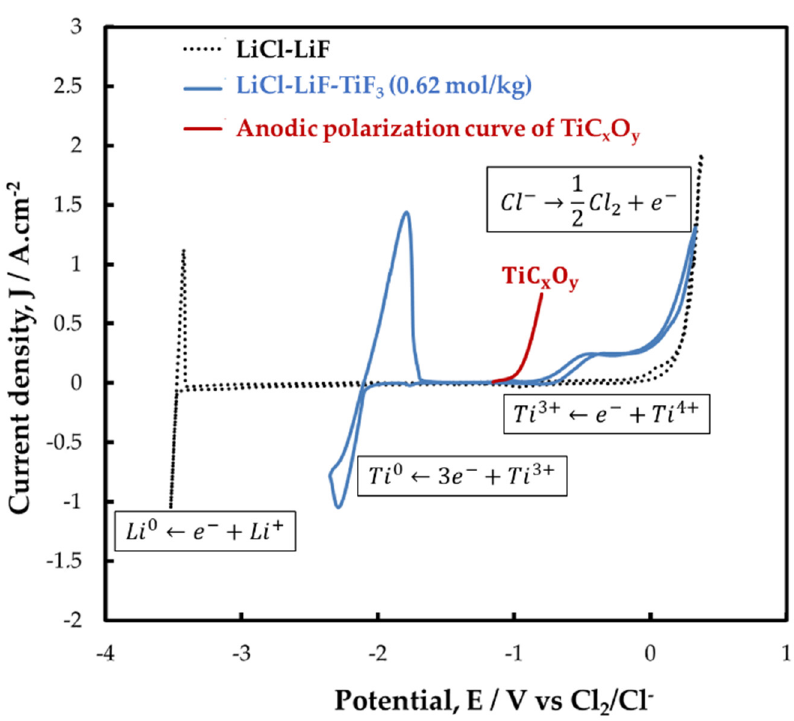
Figure 2. Cyclic voltammograms on a tungsten electrode (S = 0.2 cm 2 ) in LiCl-LiF (black) and LiCl- LiF-TiF 3 (0.62 mol/kg) (blue) and anodic polarization curve of TiC x O y (Red), at 853 K with the scan rate of 100 mV·s − 1 .